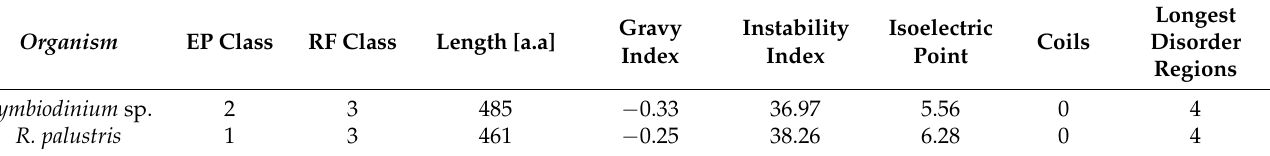
Table 2. Results for Symbiodinium sp. and R. palustris Rubisco from the crystallization prediction server XtalPred. Organism EP Class RF Class Length [a.a] Symbiodinium sp. 2 3 EP class (Expert Pool class, score from 1 (best) to 5 (worst)) is a prediction made by combining individual crystallization probabilities calculated for eight protein features into a single crystallization score. Based on this score, the protein is assigned to one of the five crystal- lization classes. RP (Random Forest Classifier, score from 1 (best) to 10 (worst)) has been extended with other protein features for example surface ruggedness, hydrophobicity, side-chain entropy of surface residues, and based on this score protein is assigned to one of the eleven crystallization